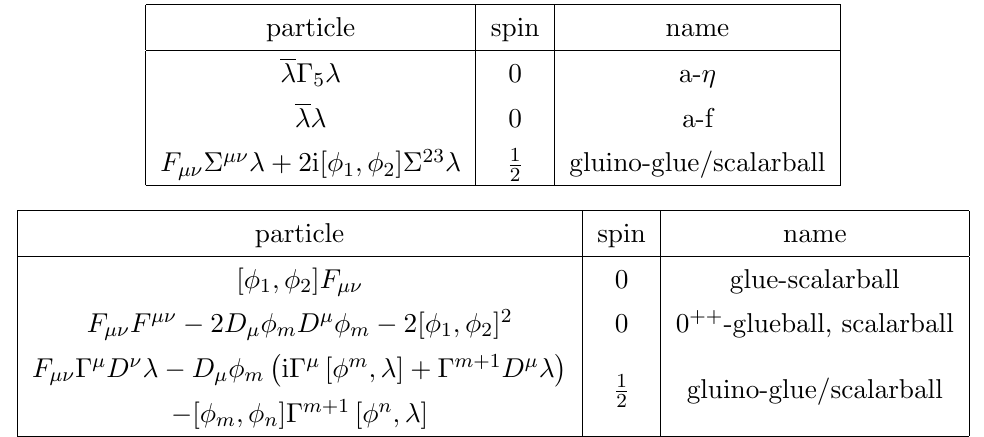
Table 2. Two-dimensional reduced super-multiplets for the N = (2 ; 2) theory. In the main body of the text we will call F (cid:22)(cid:23) (cid:6) (cid:22)(cid:23) (cid:21) the gluino-glueball and [ (cid:30) 1 ; (cid:30) 2 ](cid:6) 23 (cid:21) the